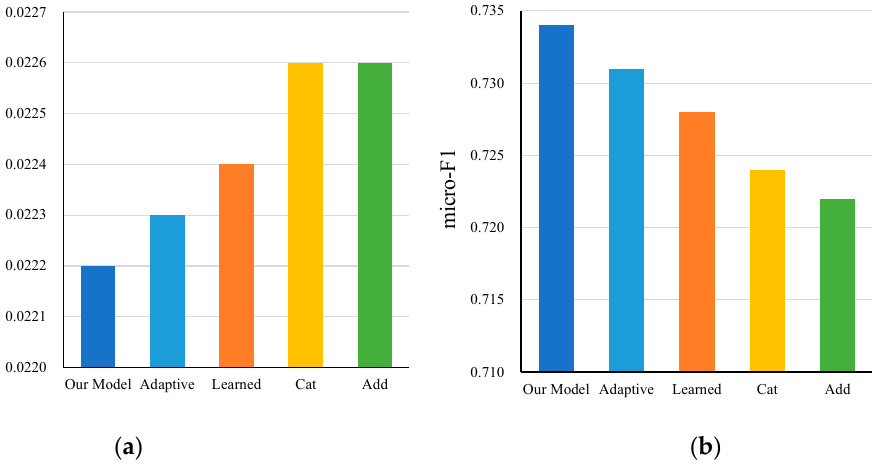
Figure 3. Comparison results of fusion strategies, including ( a ) HL results and ( b ) micro-F1 results.